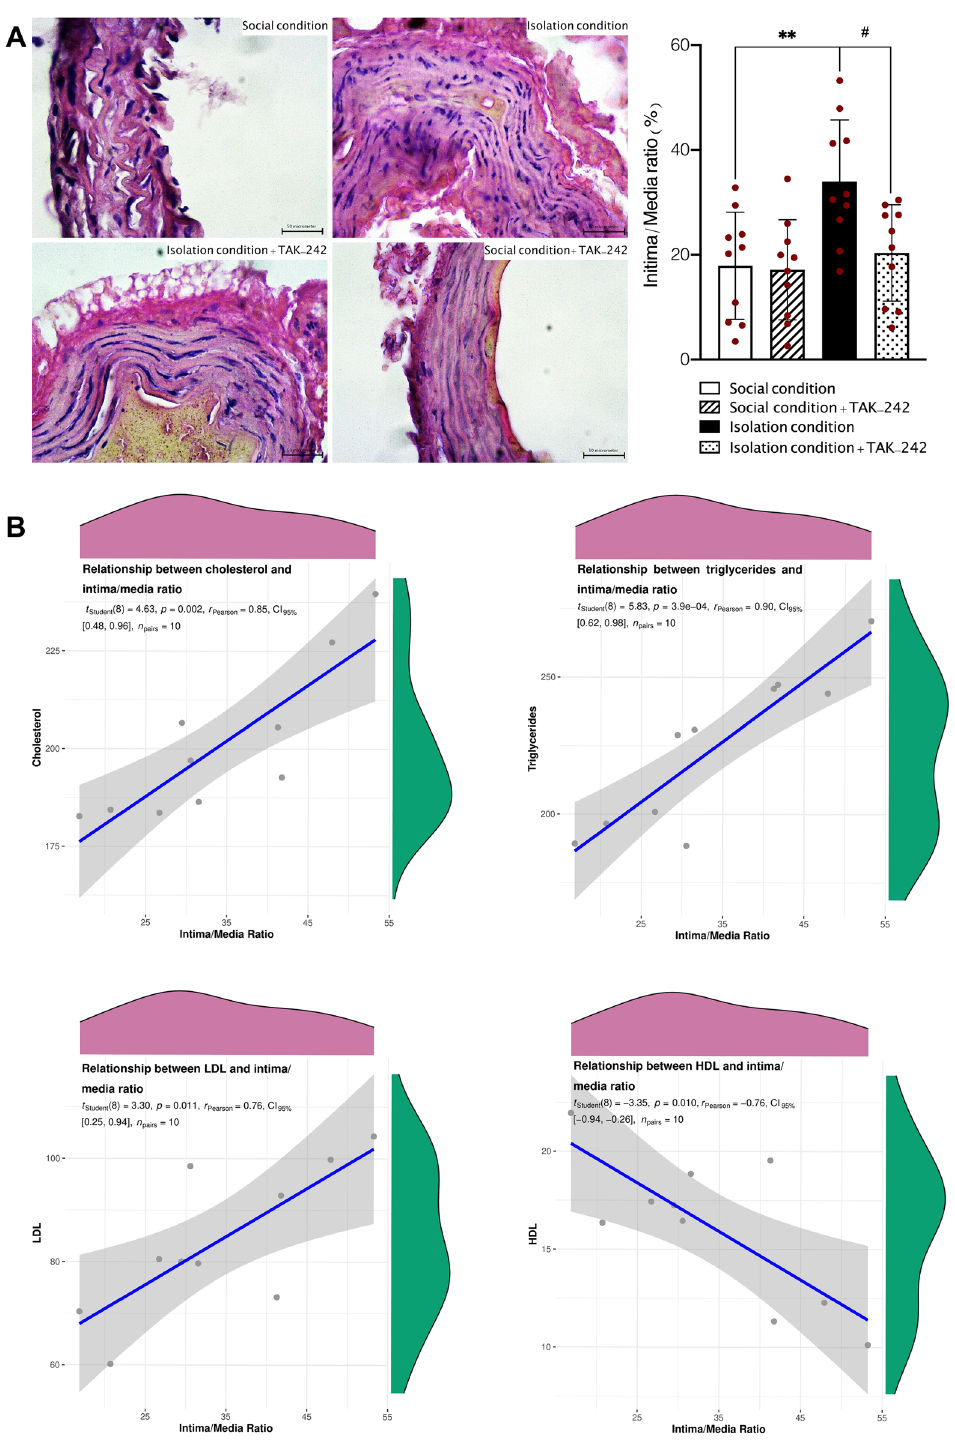
Figure 7. Pre-atherosclerotic changes and intimal/media ratio assessment in social and isolation conditioned animals treated with TAK-242 in comparison to social conditioned animals (40× magnification, A ); correlation analysis between the level of lipid profile components and intimal/media ratio ( B ). Values are expressed as the mean ± S.E.M. (n = 10 in each group) results were analyzed using One-Way ANOVA followed by Tukey’s post hoc test. ** P < 0.01 compared to social conditioned animals. # P < 0.01 compared to isolation conditioned